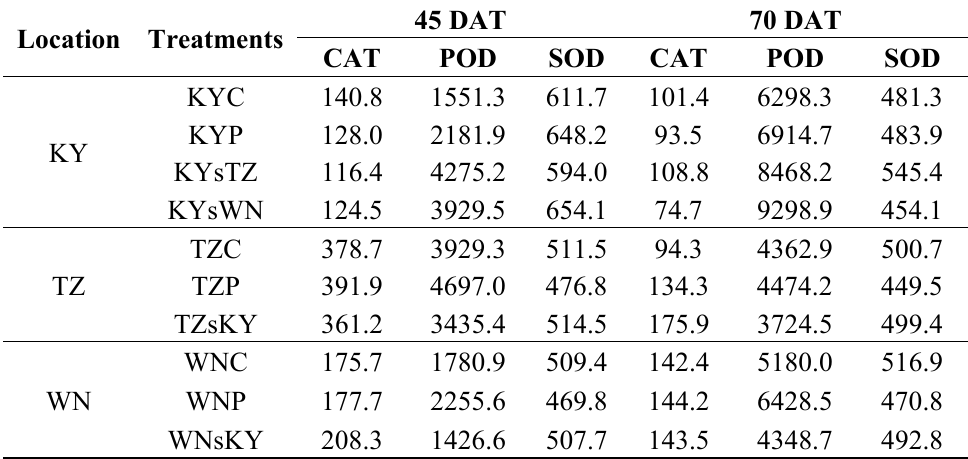
Table 3. CAT, POD and SOD activities of tobacco